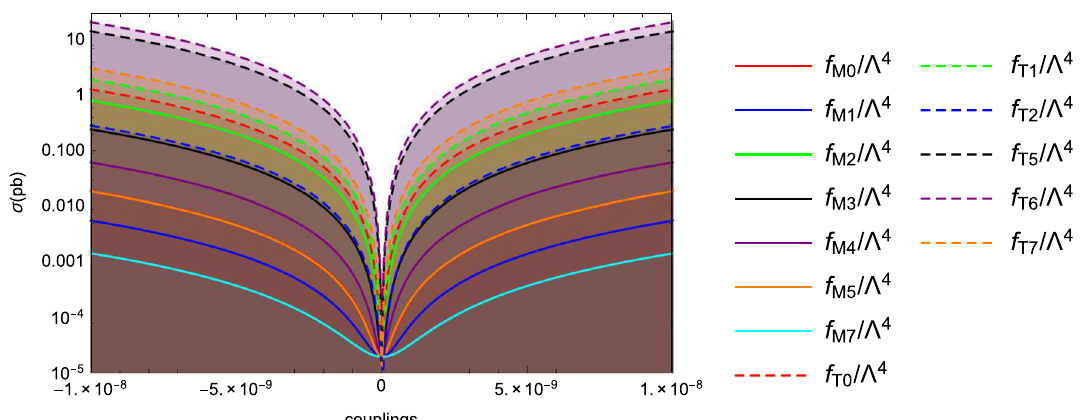
Fig. 4 Same as in Fig. 3, but for